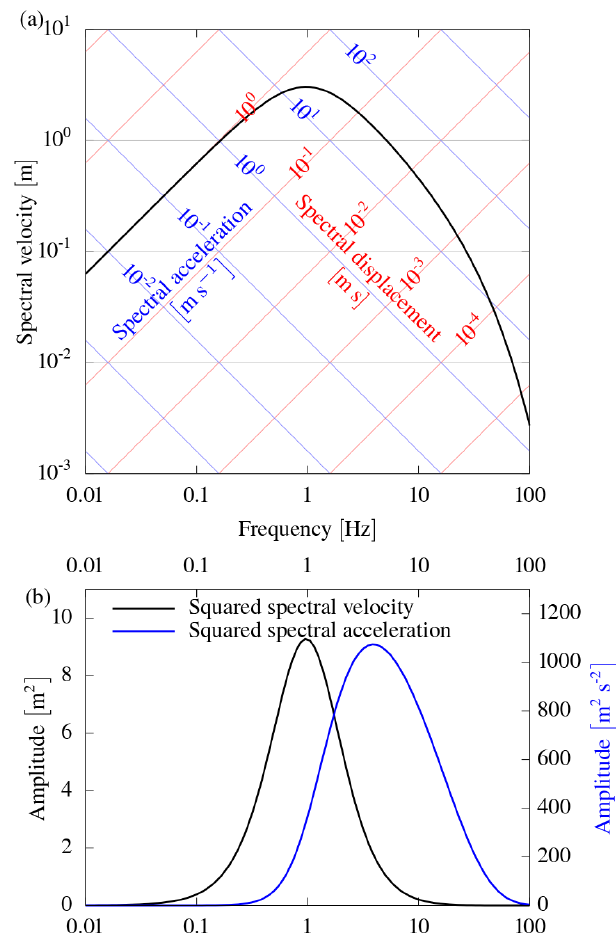
Figure 3. (a) Far-field spectrum after Brune (1970). The spec- trum can be read as displacement (red), velocity (black), and ac- celeration (blue). (b) The squared Brune spectrum corresponds to the frequency sensitivity of velocity-based IV2 (blue) and the acceleration-based I A